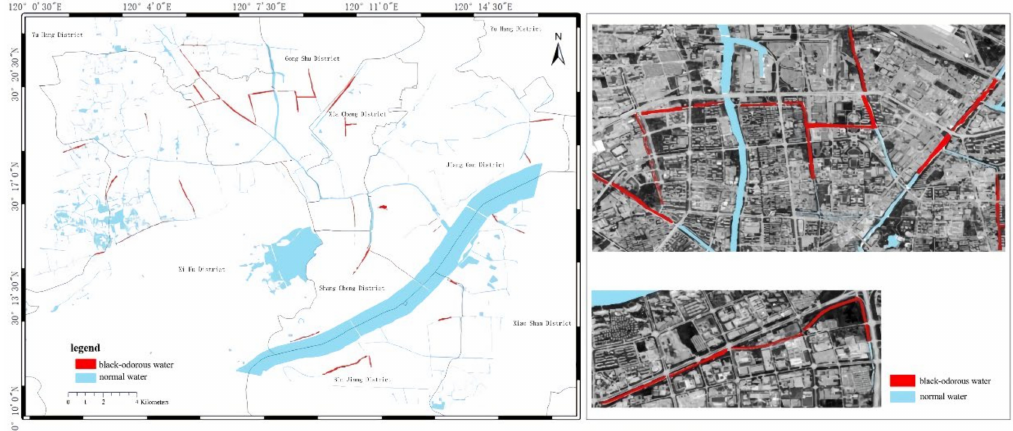
Figure 11. Distribution map of black-odorous water in